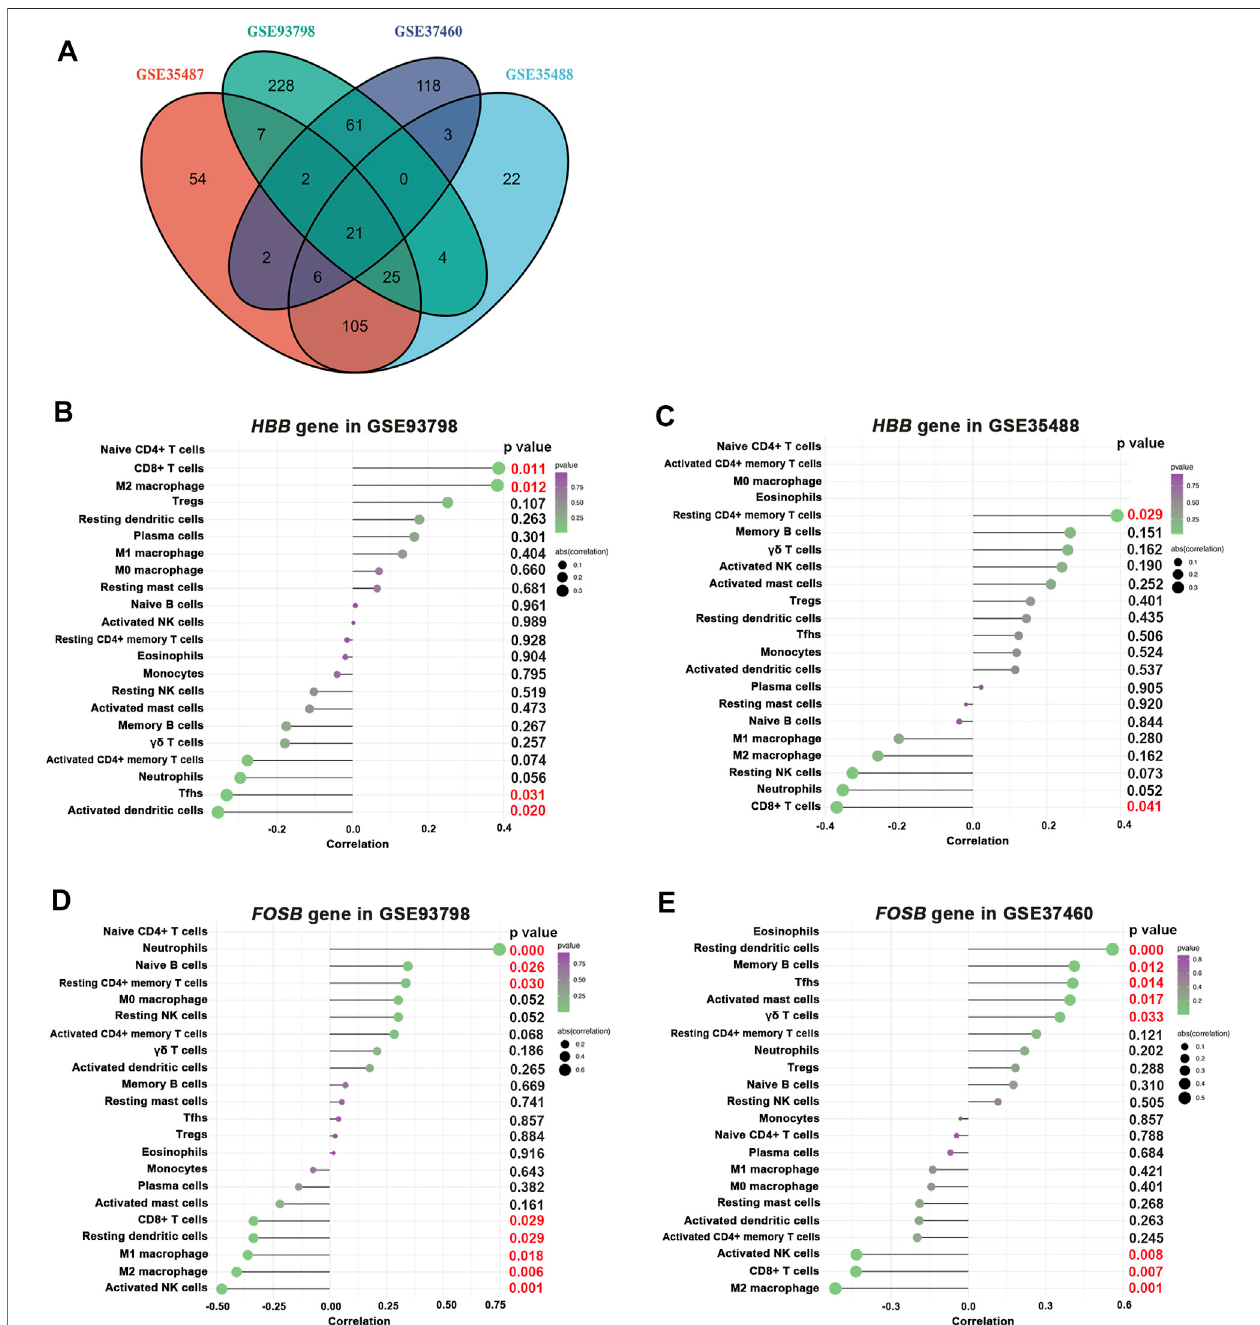
FIGURE 8 | Correlation between HBB , FOSB gene, and in fi ltrating immune cells. (A) Overlapping DEGs among all selected four GEO datasets. (B,C) Correlation between HBB gene and in fi ltrating immune cells in GSE93798 and GSE35488, respectively. (D,E) Correlation between FOSB gene and in fi ltrating immune cells in GSE83798 and GSE37460,